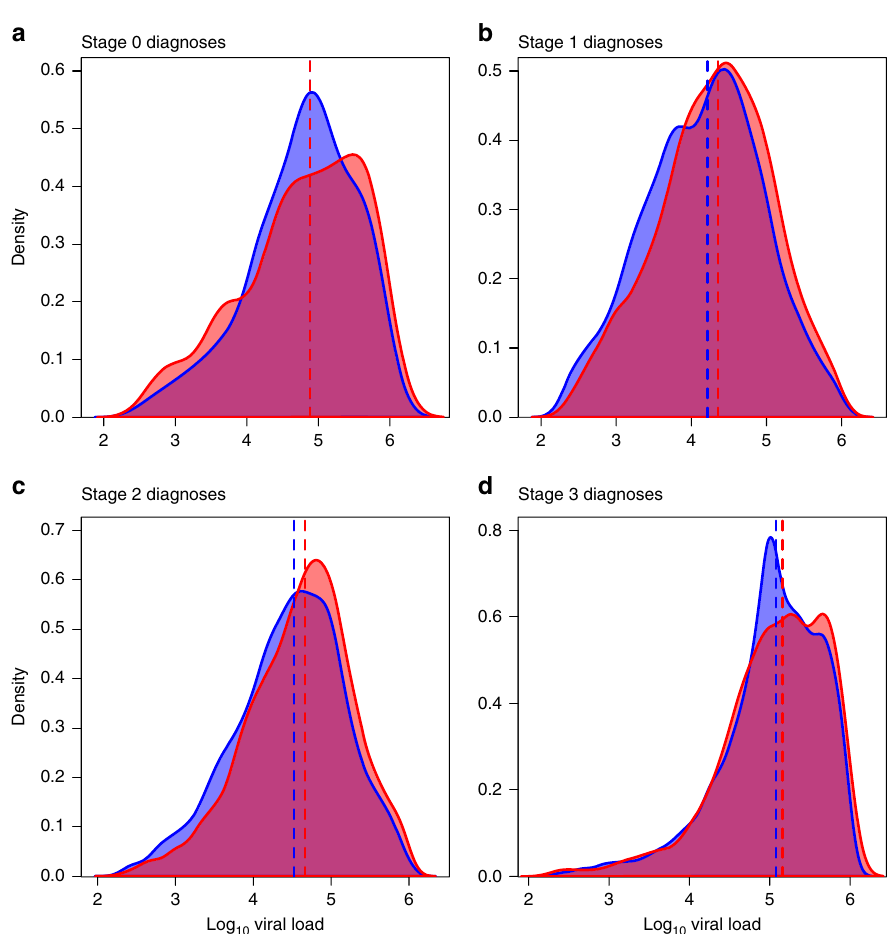
Fig. 1 Density distributions for log 10 viral load at diagnosis by network clustering. Viral loads (copies/ml) for individuals with a stage 0, b stage 1, c stage 2, and d stage 3 infection at diagnosis are displayed separately. Viral loads (copies/ml) from individuals who clustered in the network shown in red; individuals who are not clustered in the network shown in blue; overlap shown in purple. Median values are depicted as dashed lines.